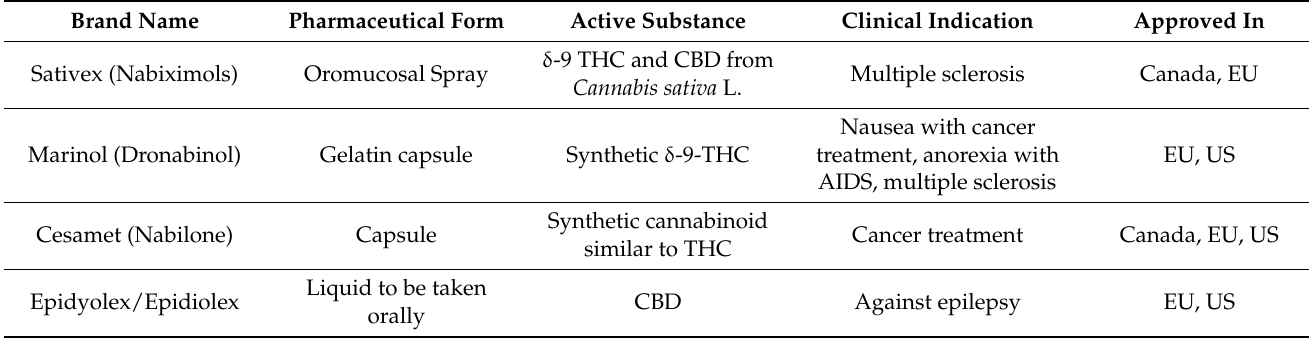
Table 1. Non-exhaustive examples of authorised cannabis-based medicines in Europe and North America at a glance. Brand